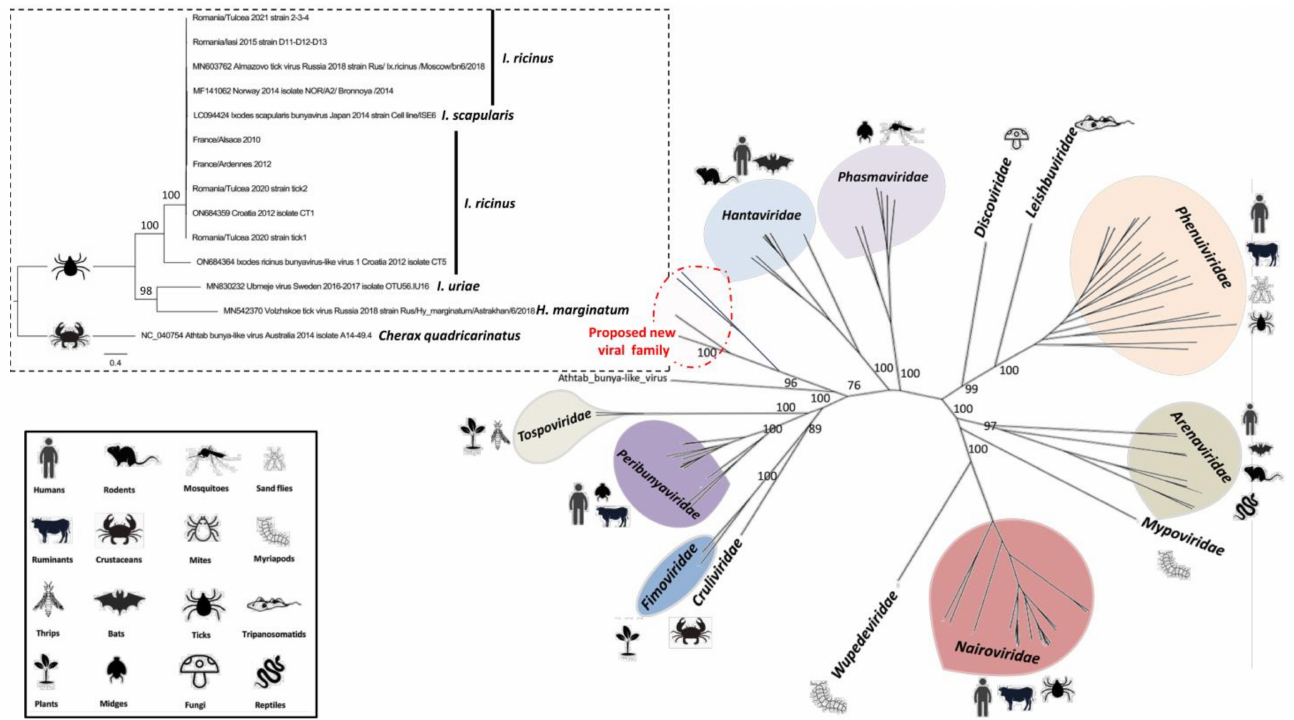
Figure 5. Phylogenetic reconstruction of the RNA-dependent RNA polymerase of Bunyavirales . Repre- sentative complete amino-acid sequences of the thirteen families comprising the order were selected (details of sequences are presented in Supplementary Table S1). Only bootstrap evaluations of the clus- tering of viral families within the Bunyavirales are shown. Inset: RdRP-based amino-acid phylogenetic relationship between members of the proposed novel virus family in relation to their tick